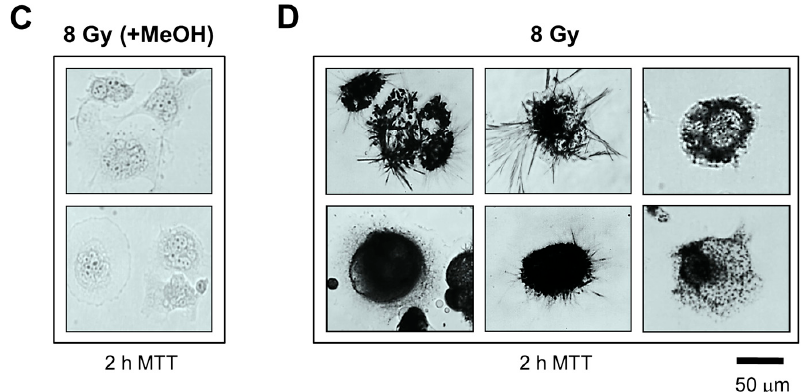
Figure 6. Bright-field microscopy images depicting the metabolic activity of HCT116p53 − / − cultures: before ( A ); and after ( B – D ) 8-Gy irradiation. Metabolic activity was measured by the ability of the cells to convert the yellow MTT to its purple formazan metabolite, appearing as dark granules and crystals; As a negative control, cells in some dishes were first treated with methanol to inhibit their metabolic activity, and then incubated with MTT ( C ). All images were acquired at the same magnification.